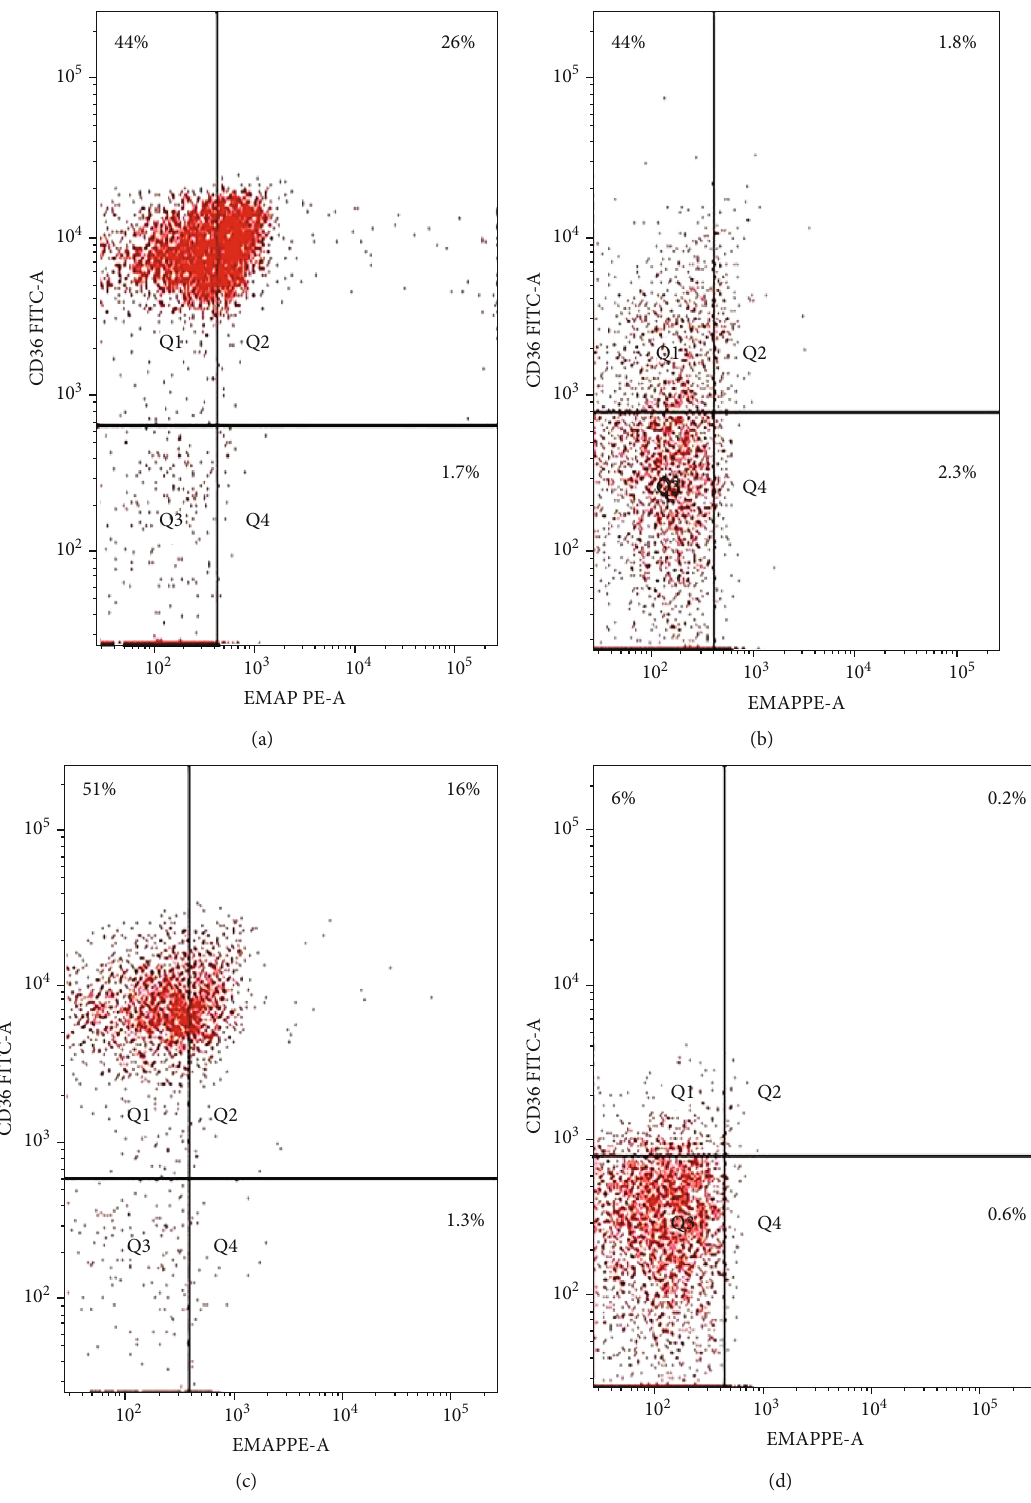
Figure 3: Flow cytometric detection of CD36 in EMAP+ lymphocytes. (a) NHL patient has not received treatment yet. (b) NHL patients achieved CR. (c) Patients with disease relapse. (d) Normal